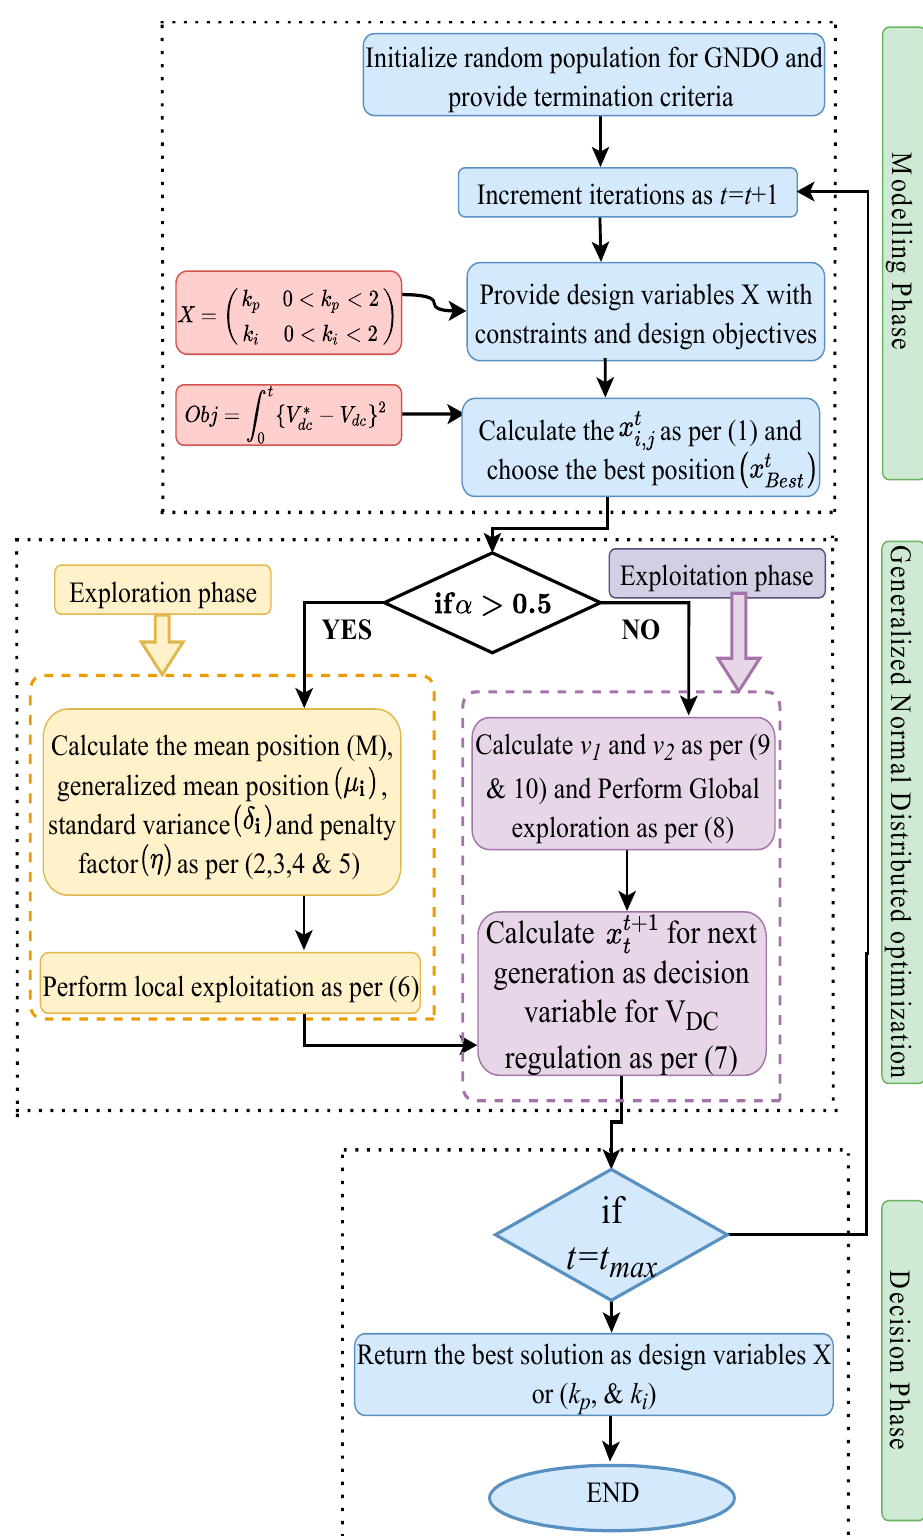
Figure 2. GNDO flow chart.